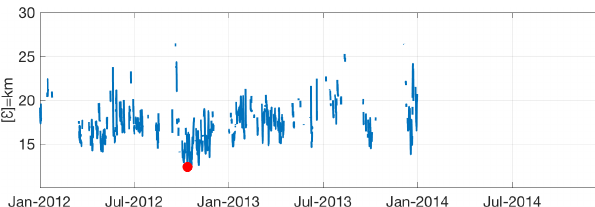
Figure 3. Example for the test period on 15 April 2015 at 00:00; errors are for all Lagrangian catalog fields of the BoB HFR system (training period 2012–2014), restricted to the δ cg = 10km condi- tion. The red dot indicates the occurrence date and the error of the best analog (19 September 2012 at 07:00).